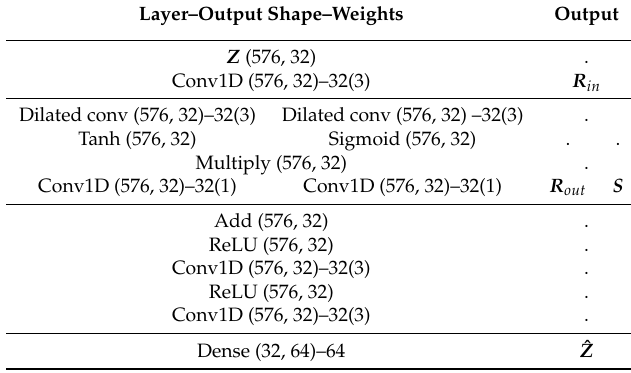
Figure 4. Block diagram of CWAFx ; adaptive front-end, latent-space WaveNet and synthesis back-end. Table 5. Detailed architecture of the latent-space